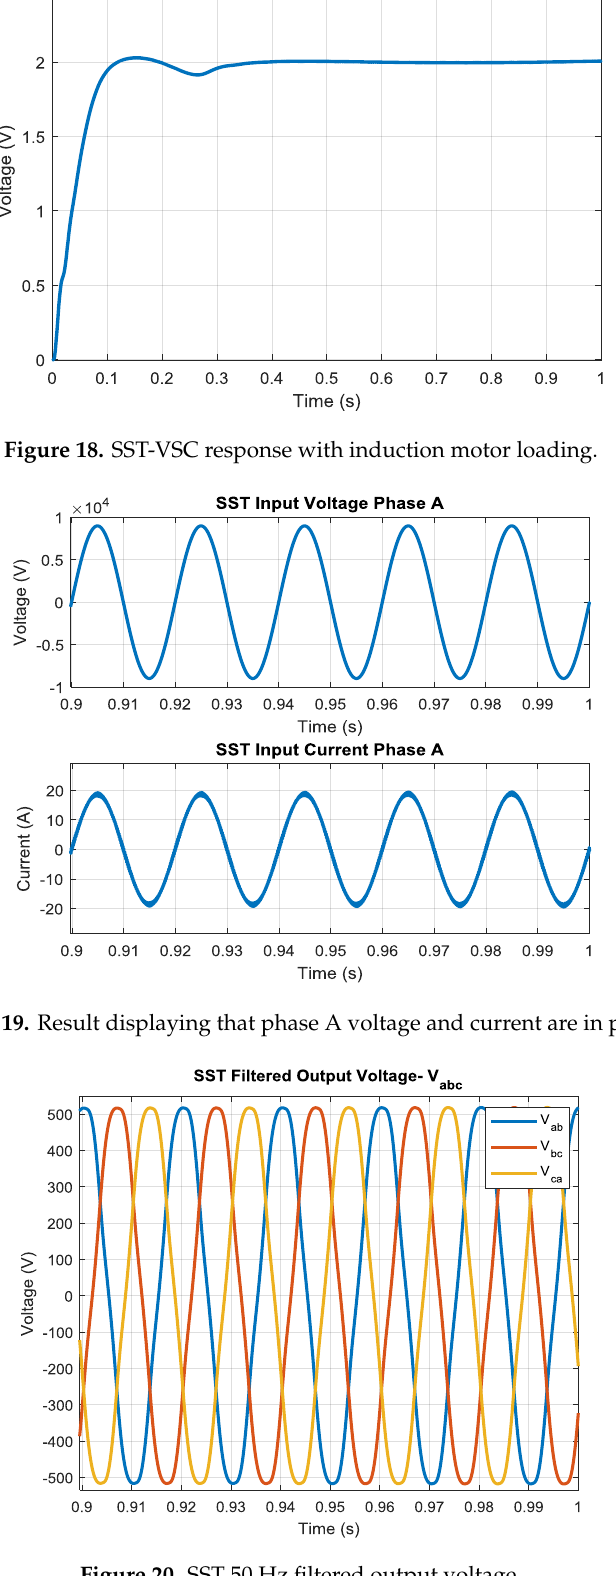
Figure 20. SST 50 Hz filtered output voltage.